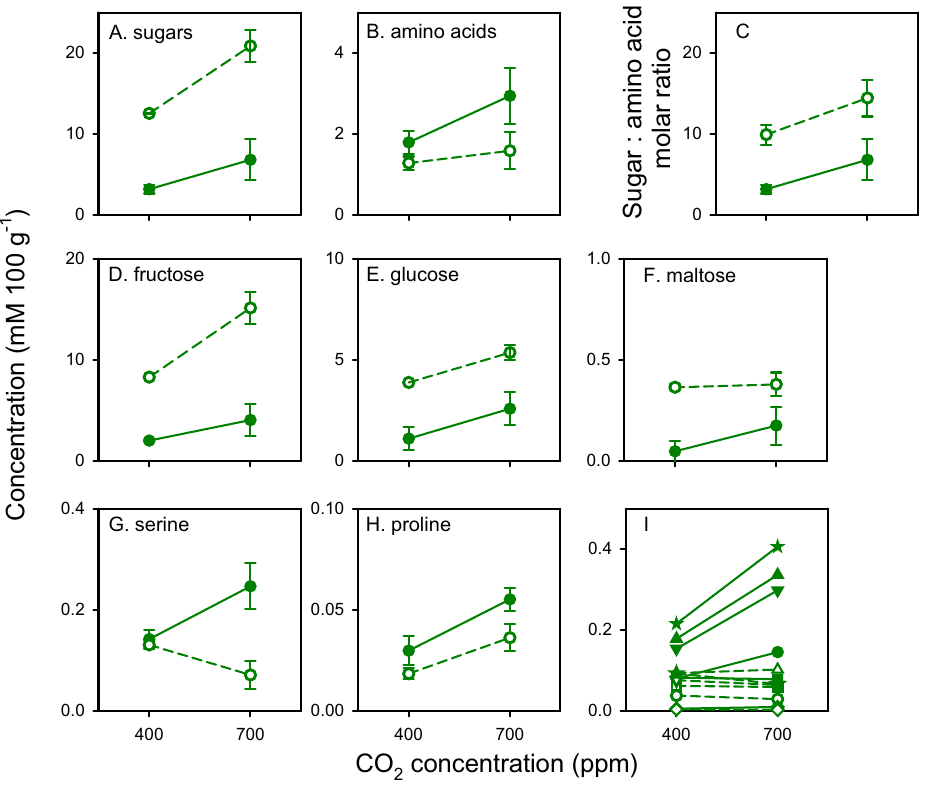
Figure 2. Effects of nitrogen (high: closed symbol, low: open symbol), [CO 2 ] and their interaction on the concentration of sugars and amino acids in wheat plants at 28 days after sowing, immediately before the establishment of aphid assays 1 and 2. ( A ) Total sugars, ( B ) total amino acids, ( C ) sugar: amino acid molar ratio, ( D ) fructose, ( E ) glucose, ( F ) maltose. ( G ) Serine, which varied with nitrogen and interaction. ( H ) Proline, which varied with nitrogen and [CO 2 ], with no interaction. ( I ) Examples of amino acids that increased concentration with high nitrogen and did not vary with [CO 2 ] and interaction: circles, valine; squares, arginine; triangles, amino butyric acid; triangles down, phenylalanine; lozenges, threonine; stars, leucine. Error bars are two standard errors of the mean and have been omitted for clarity in